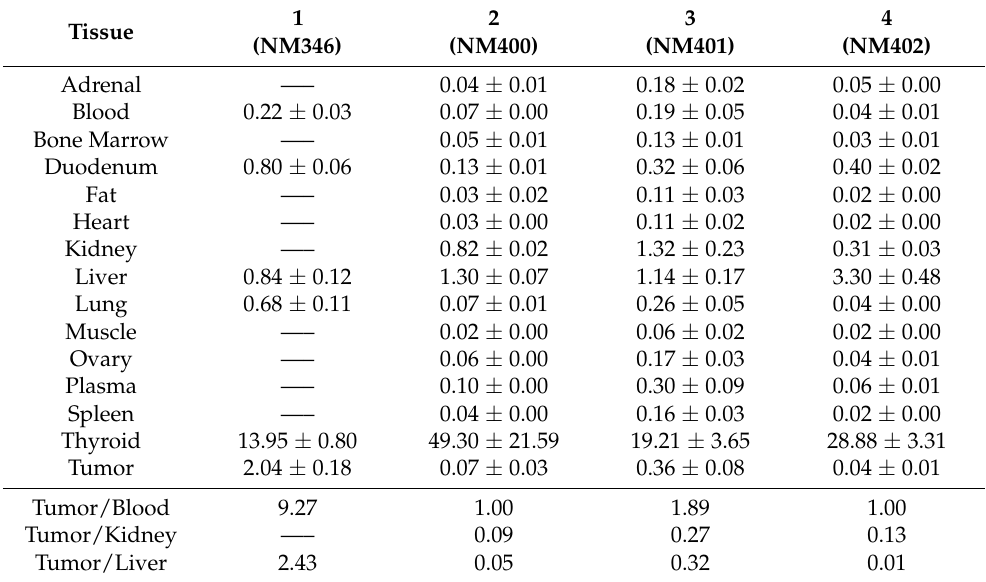
Table 1. Tissue distribution of 125 I-labeled APC analogs in tumor-bearing rats 120 h after i.v. injection a .